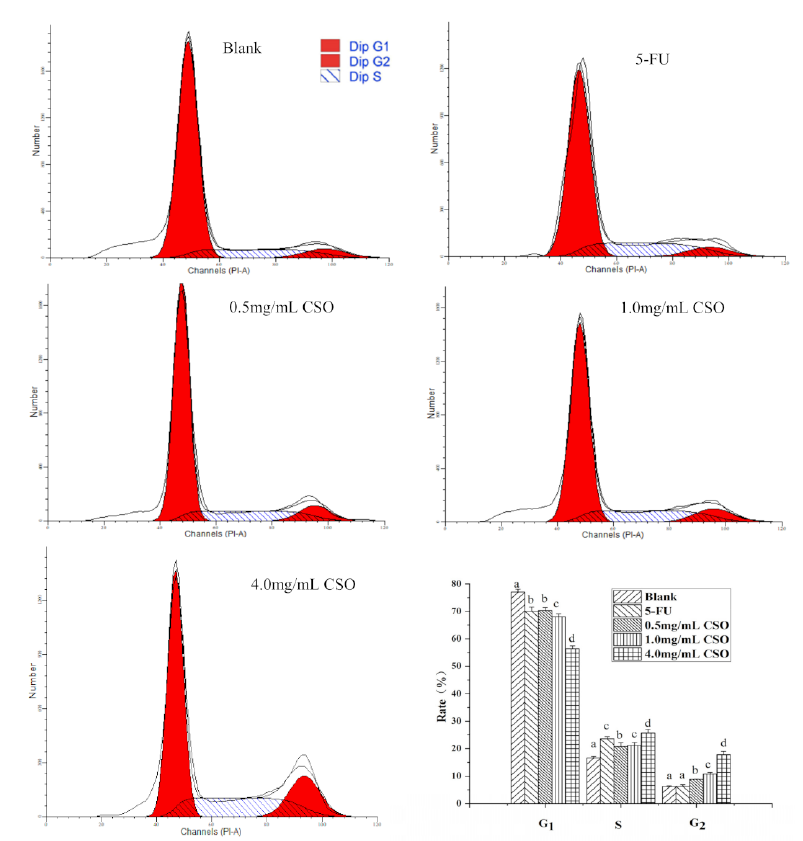
Figure 4. Cell cycle distributions of HT-29 cells in the absence and presence of CSO. Different letters indicate significant differences ( p < 0.05) according to Duncan’s test. Abbreviations: 5-FU, 5-fluorouracil; CSO, coix seed